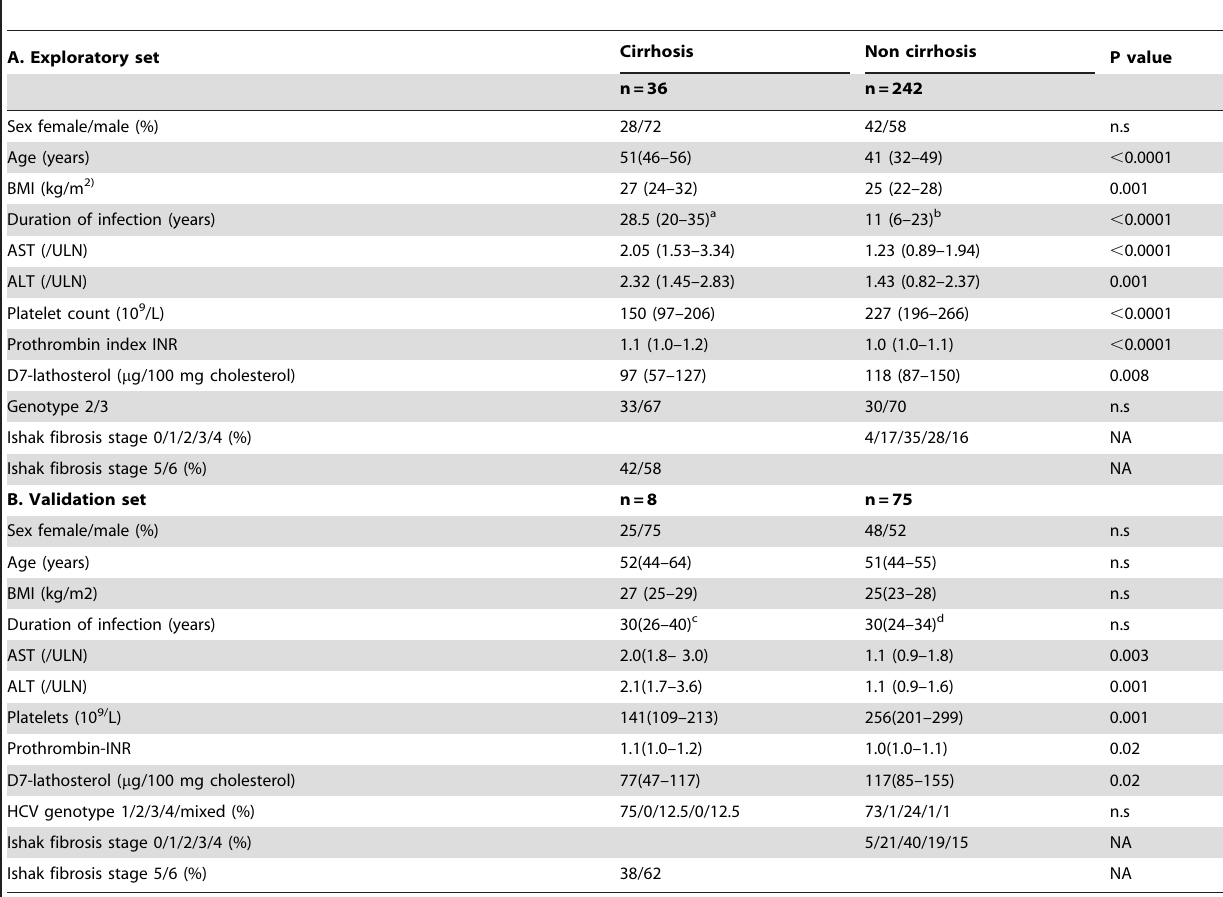
Table 1. Baseline characteristics in the (A) exploratory set and (B) the validation set according to presence of cirrhosis in liver